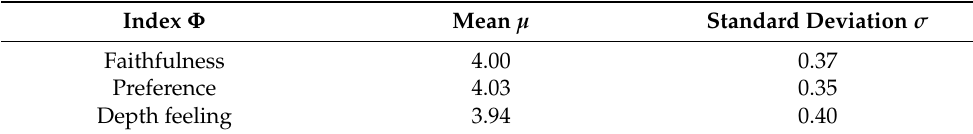
Figure 8. Fitting results for each evaluation index by proposed estimation model. ( a ) Faithfulness; ( b ) Preference; ( c ) Depth feeling. Table 3. Mean and standard deviation values of estimation model.